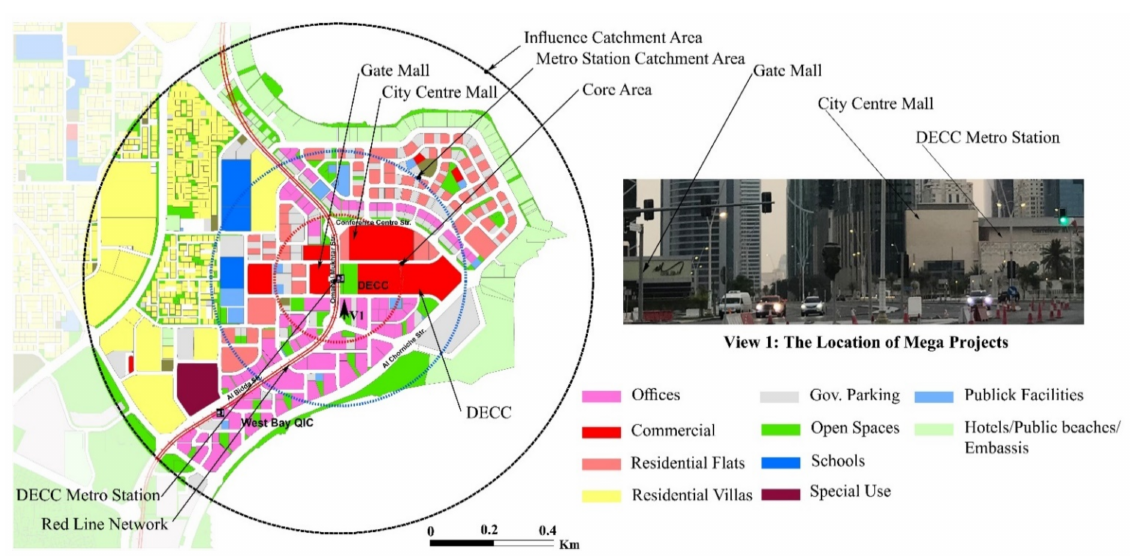
Figure 7. Master Plan of DCA of DECC metro